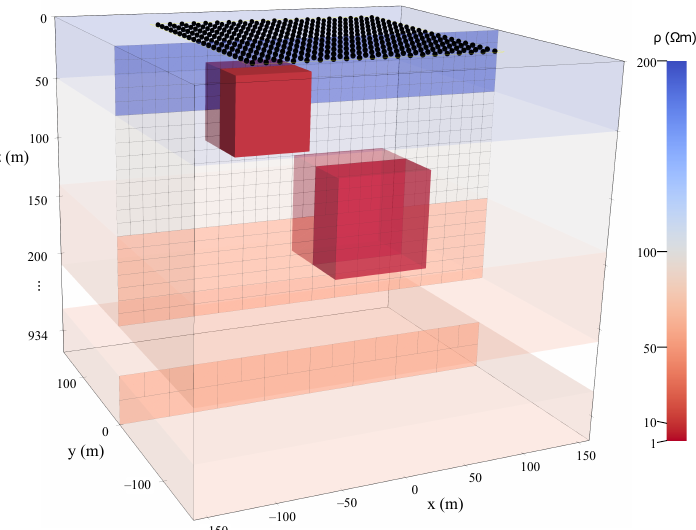
Figure 6. Example 2: model, measurement configuration, and MR grid discretization (central region). Yellow line and black points denote loop source and observation sites, respectively. Discretization of air layers is the same as in Example 1 and is omitted